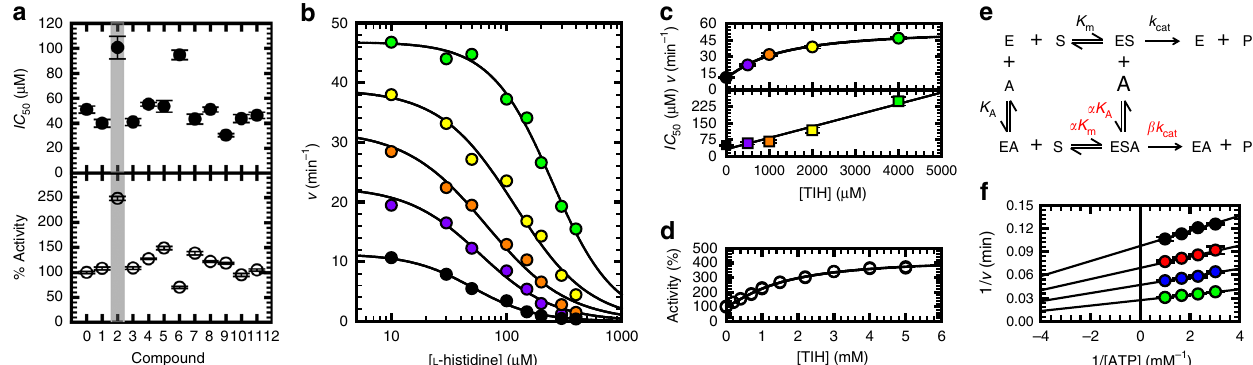
Fig. 2 CoSPI discovery of a non-essential activator of ATP-PRT. a L -His IC 50 and %Activity data obtained in the presence of each of 11 L -His analogues using CoSPI. The dashed lines mark L -His IC 50 and the activity of uninhibited ATP-PRT. Error bars indicate the s.d. Number of replicates ( n ) = 3 b Representative inhibition curves determined for L -His in the presence of 0 ( black ), 0.5 ( purple ), 1 ( orange ), 2 ( yellow ) and 4 ( green ) mM compound 2, TIH (shown in the upper right corner ). Circles are experimental measurements and lines the best fi t to Eq. 2 in Methods section. c Replot of the data in b , showing hyperbolic increase in ATP-PRT activity ( circles ) and linear increase in L -His IC 50 ( squares ), in the presence of TIH. The lines are the best fi t to Eq. 1 in Methods and a linear regression of the data, respectively. Error bars indicate the s.e.m. d Steady-state kinetics of ATP-PRT activation by TIH. Circles are data points and the line is the best fi t to Eq. 3 in Methods section, n = 2. e General modi fi er mechanism depicting an activator, E, enzyme; S, substrate; A, activator; P, product. f Double-reciprocal plot highlighting the non-essential activation pattern obtained when varying the concentration of TIH. Circles are data points obtained with 0 ( black ), 0.25 ( red ), 0.8 ( blue ) and 4 ( green ) mM TIH and lines are the best fi t of the entire data set to Eq. 4 in Methods section. Error bars indicate the s.d., n =